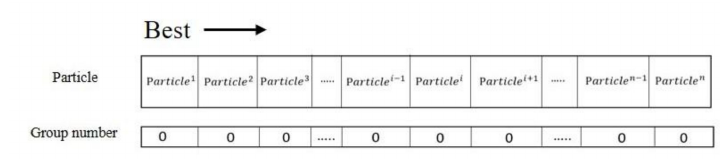
Figure 4. Sorting diagram of particles.